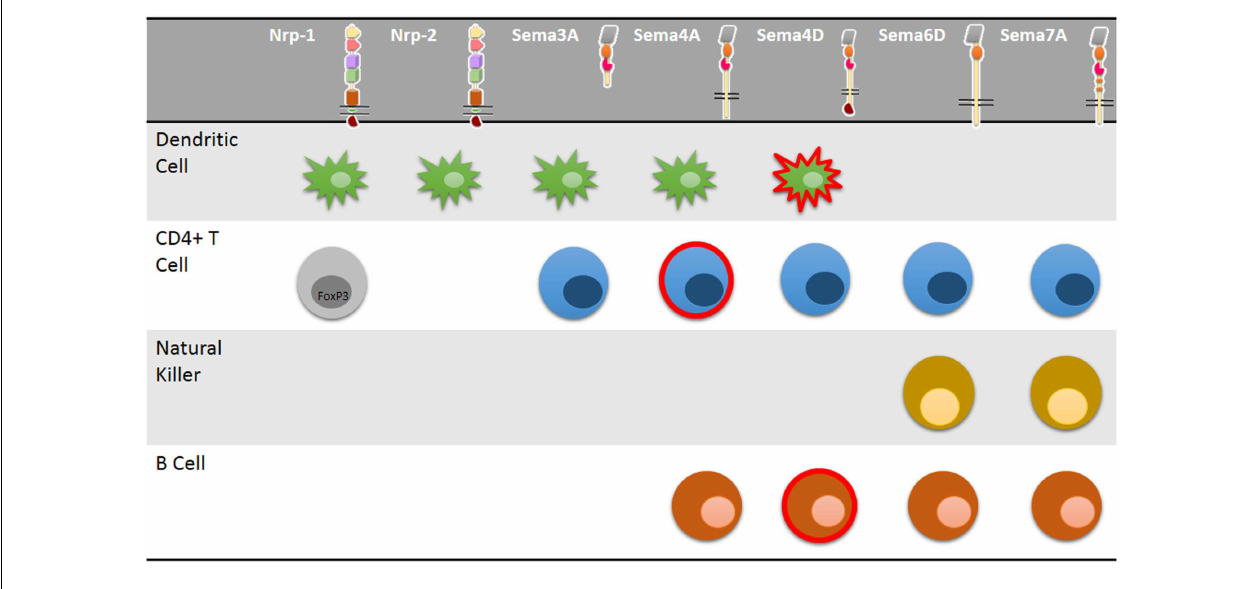
response and CD4 + T-cell polarization. Some neuropilins and semaphorins are uniquely expressed in specific CD4 + T-cell subsets such as activated cells (red lined cells) or FoxP3 + regulatoryT cells (gray